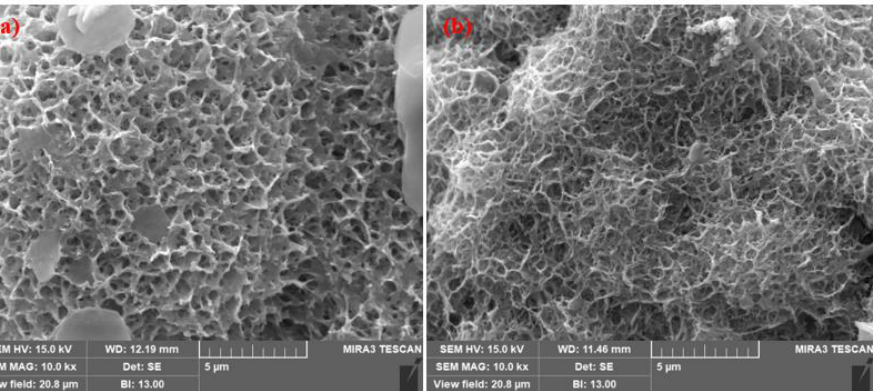
Figure 12. SEM images of corrosion products at 10,000× formed on the zinc coatings deposited by the ( a ) arc thermal spray and ( b ) plasma arc thermal spray processes after 23 d of exposure to artificial seawater.